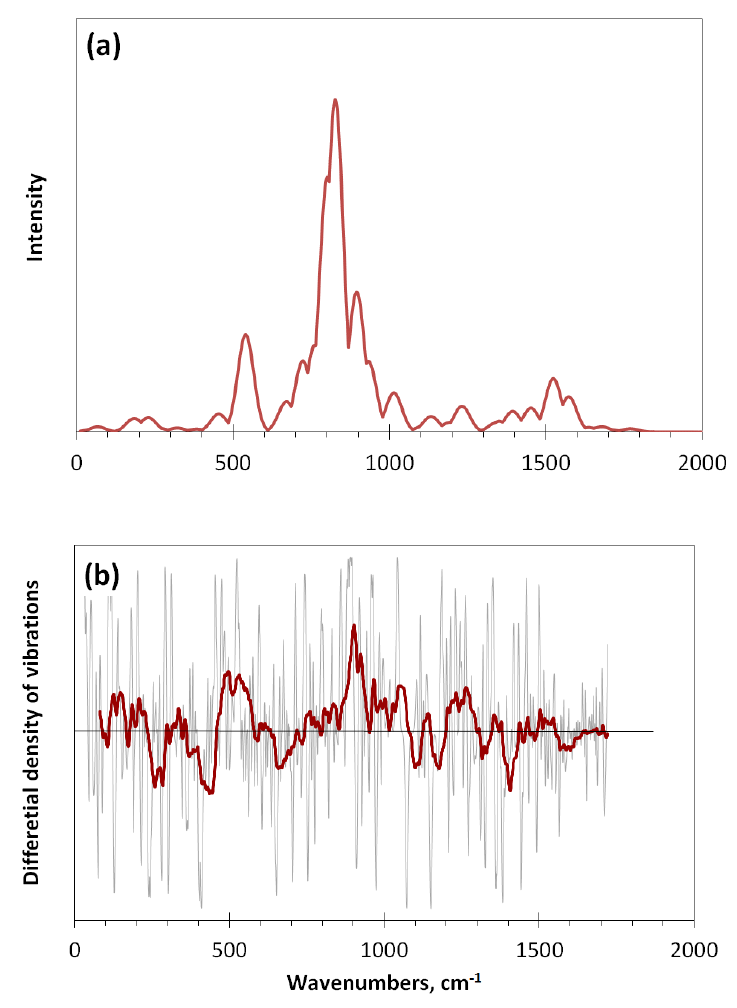
Figure 4. ( a ) The virtual one-phonon IR spectrum of DT II . The Gaussian convolution of the original stick bars performed with a FWHM of 60 cm − 1 . ( b ) Differential DOV spectrum ∆ V 3 . Trendline corresponded to 50-point linear filtration. UHF AM1 calculations.